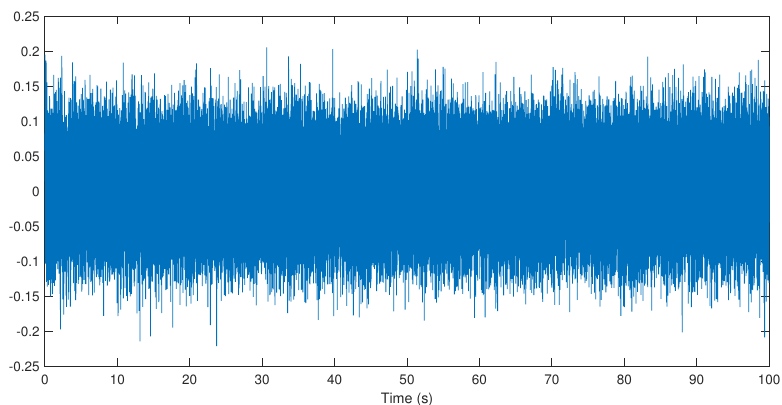
Figure 7. Numerical results for the noisy case: e i ( t )